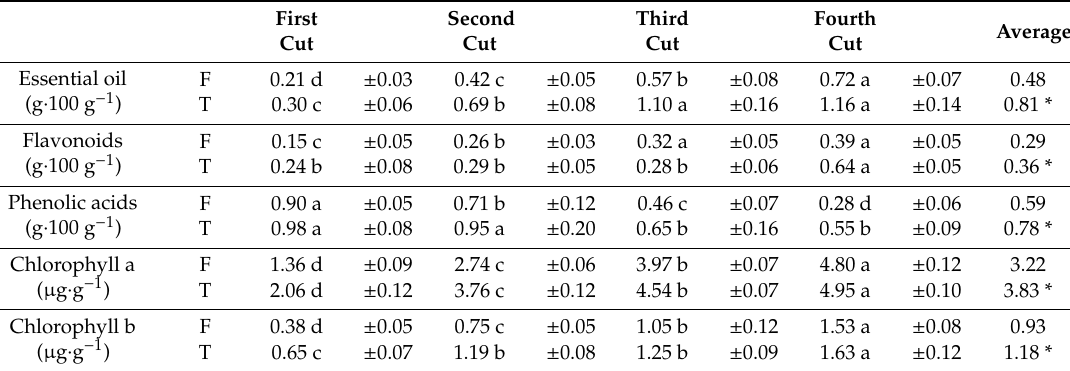
Table 5. Total content of essential oil, phenolic compounds (g · 100 g − 1 ), and chlorophyll ( µ g · g − 1 ) in the air-dried